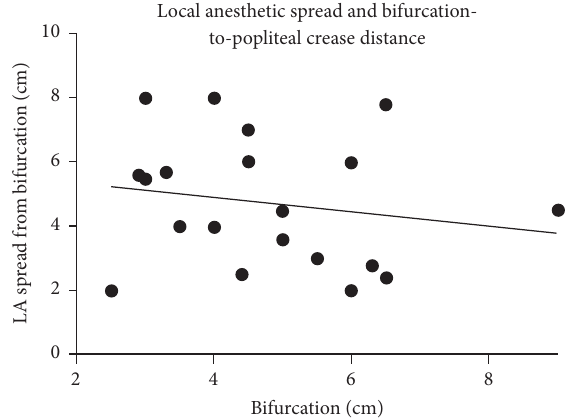
Figure 3: Scatter plot showing the relationship between bifurcation length and excess spread of local anesthetic. Excess spread was measuredasthedistancebetweenthebifurcationpointandmaximal spread of local anesthetic proximal to the bifurcation. A negative correlation was found between the excess spread of local anesthetic and bifurcation length, 𝑟 = −0.5605 , 𝑝 = 0.01